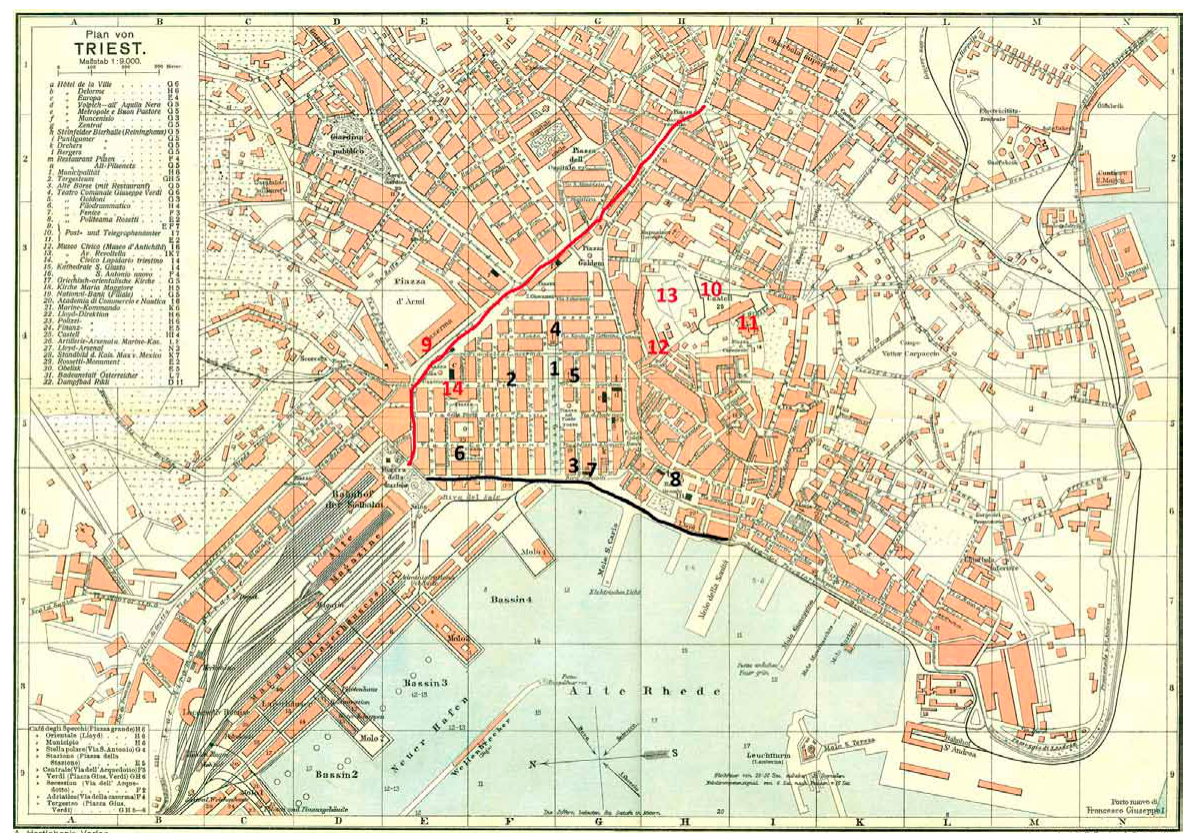
fig. 4. Trieste city plan, early 20 th century (Hartleben’s Verlag). 1. Canal Grande; 2. Borgo Teresiano; 3. Carciotti Palace; 4. St. anthony Church; 5. St. Spiridione Church; 6. lutheran Church; 7. St. nicholas Church; 8. Piazza Grande). 9. austrian barracks; 10. St. Giusto Castle; 11. St. Giusto Cathedral; 12. roman theatre (discovered in the 1930s); 13. remembrance Park (after WW1); 14. narodni dom. In black: Habsburg Trieste’s main urban axis. In red: Trieste main urban axis in the 1920s and